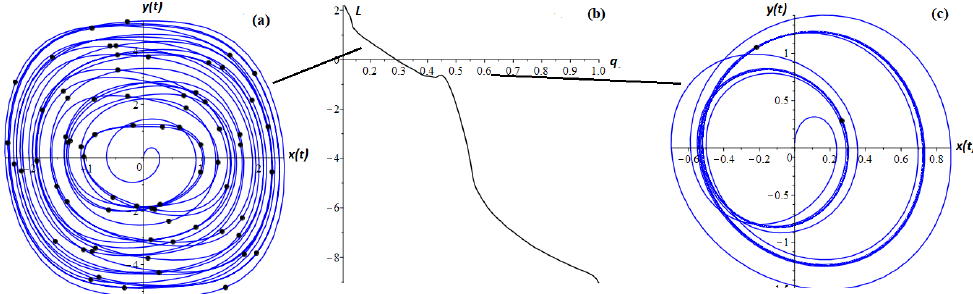
Figure 9. ( a ) Phase trajectories at q = 0.15, ( b ) the spectrum of Lyapunov exponents from q and ( c ) phase trajectories at q = 0.6. The dots represent the Poincare sections.